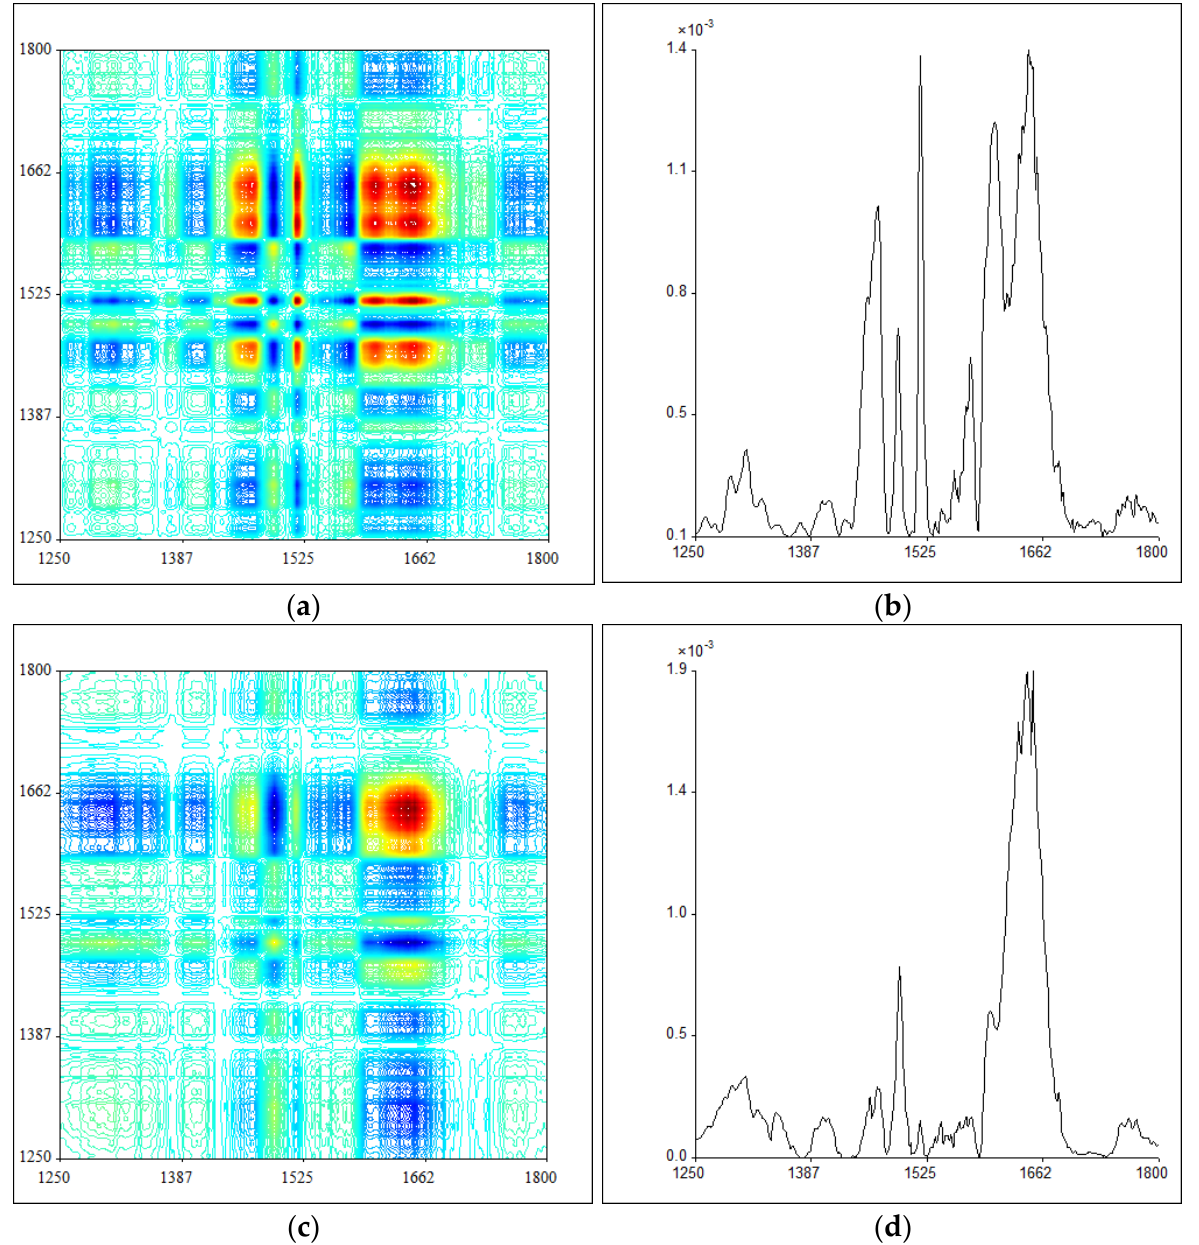
Figure 4. The synchronous two-dimensional correlation infrared (2DIR) spectra of pterocarpus bracelet (PB) ( a ) and P. santalinus ( c ) at 1250–1800 cm − 1 and the corresponding automatic peaks distribution of pterocarpus bracelet (PB) ( b ) and P. santalinus ( d ). Table 3. Autopeak intensity in the two-dimensional correlation infrared (2DIR) spectra of pterocarpus bracelet (PB) (A) and P. santalinus (B) at 1250–1800 cm − 1.